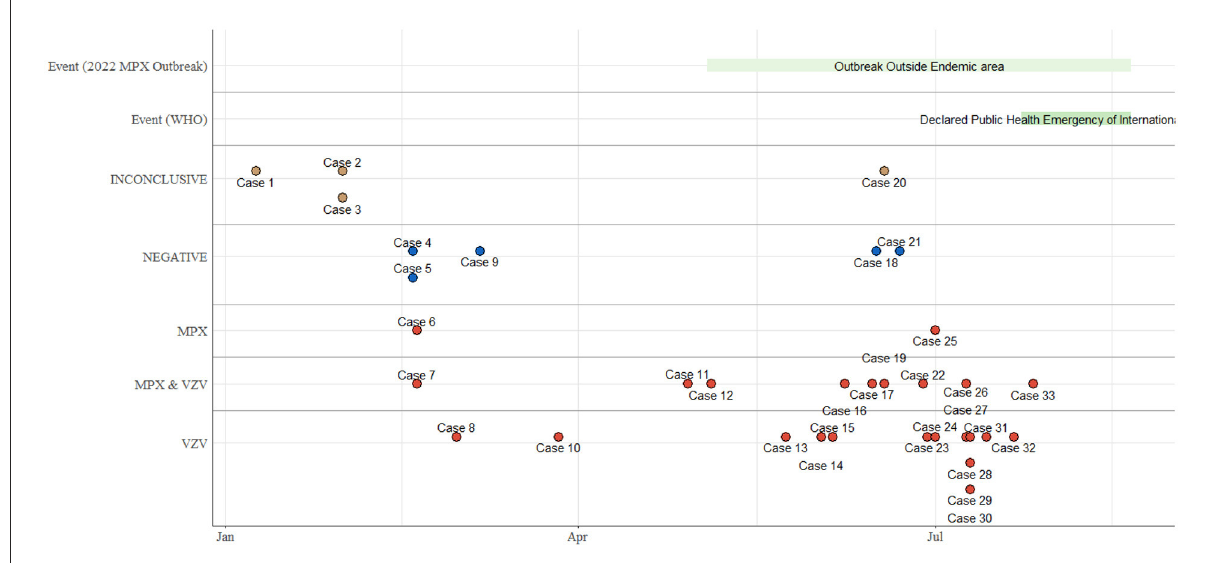
FIGURE3 Epidemiological timeline of the outbreak of MPX in Adamawa State.